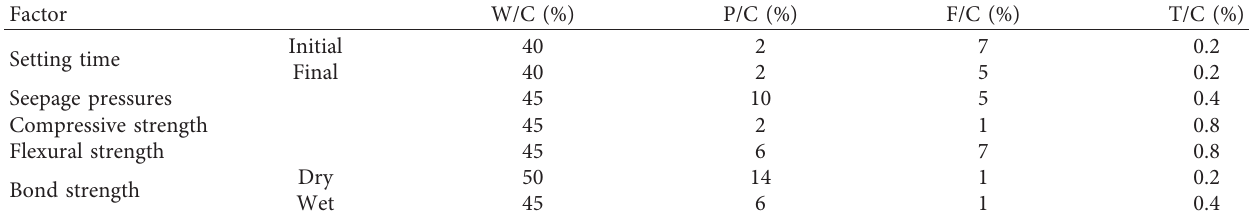
Table 11: Optimal ratio of TSL.